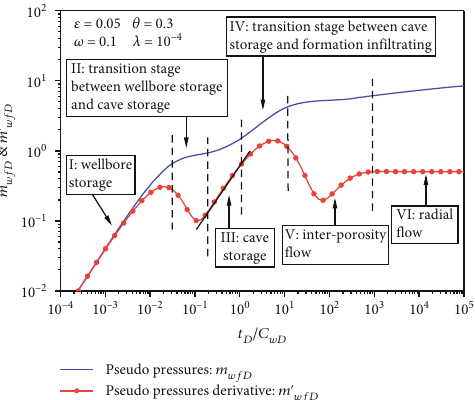
Figure 7: The typical curves comparison of Wu ’ s model and our